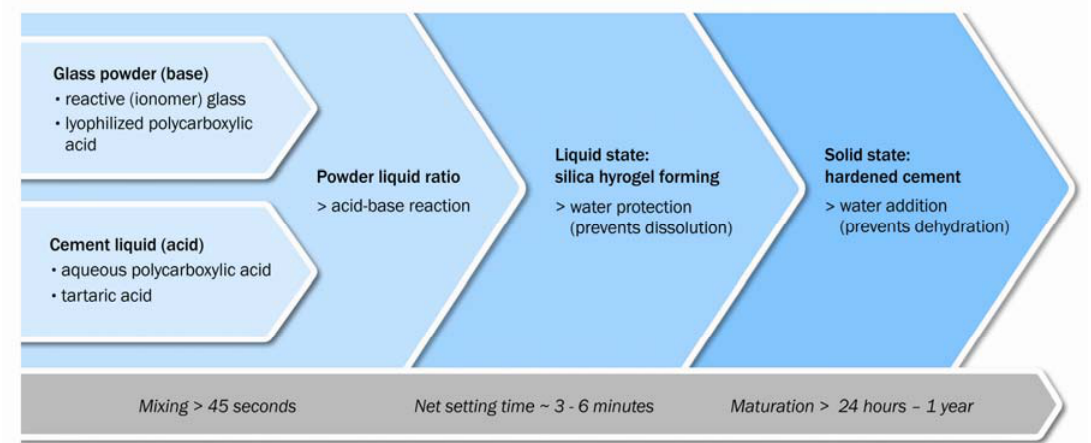
Figure 3. Principal setting stages during cement